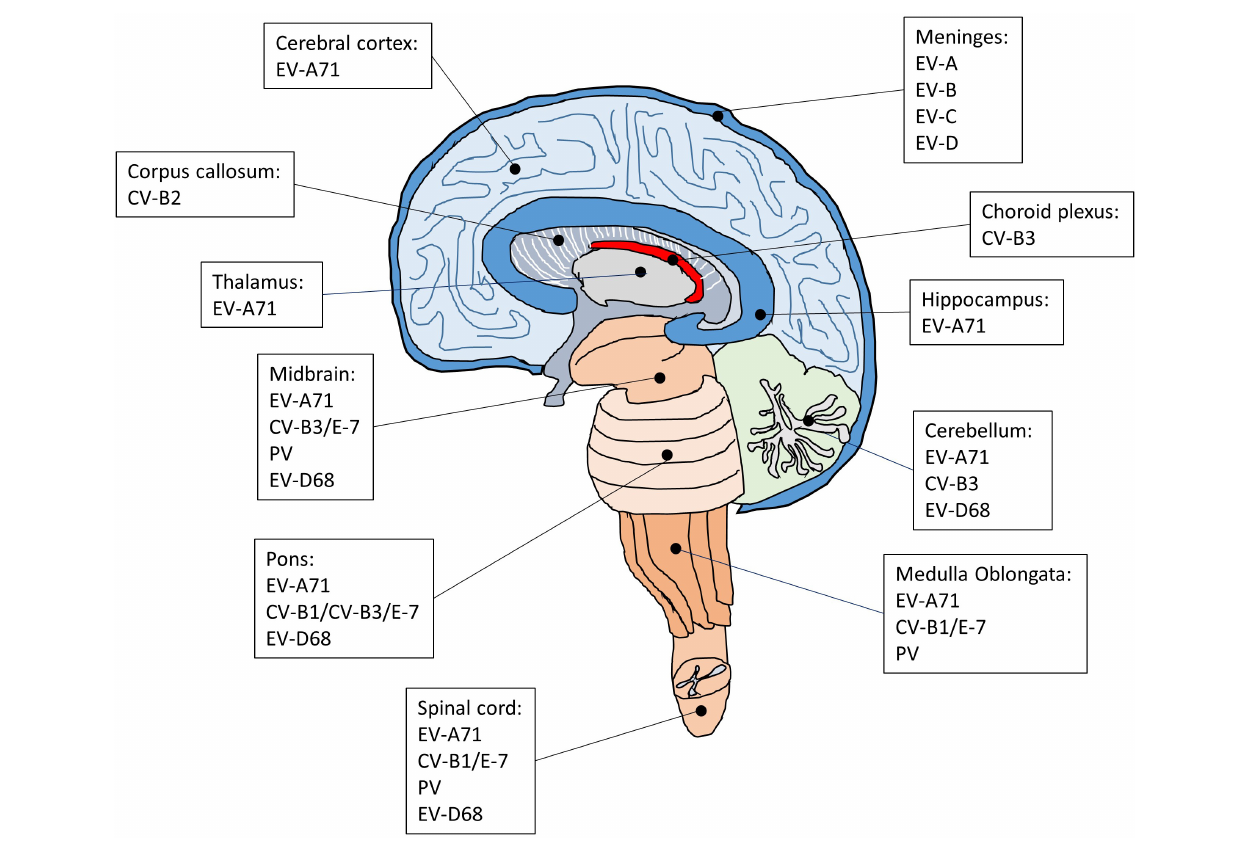
FIGURE 2 | The regions of the CNS affected by enteroviruses that cause encephalitis, meningitis and AFP. The CNS is composed of cerebrum, diencephalon, cerebellum, brainstem, and spinal cord. Following enteroviral infection of the CNS, inflammation can occur in different anatomical regions such as the brain (encephalitis), meninges (meningitis), and spinal cord (myelitis), or simultaneously in multiple regions (meningoencephalitis,